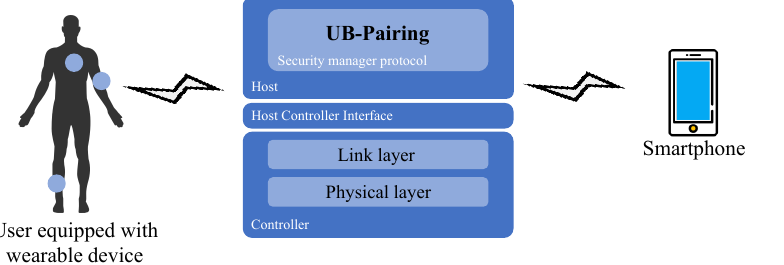
Figure 1. System model of wearable device